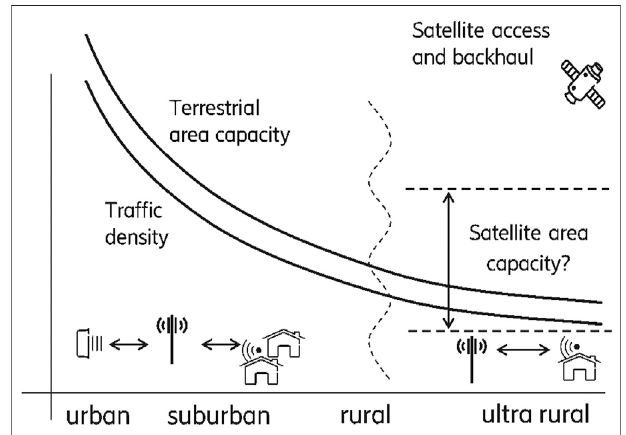
FIGURE 1 | Positioning of terrestrial and satellite network technology considering different levels of capacity and traf fi c